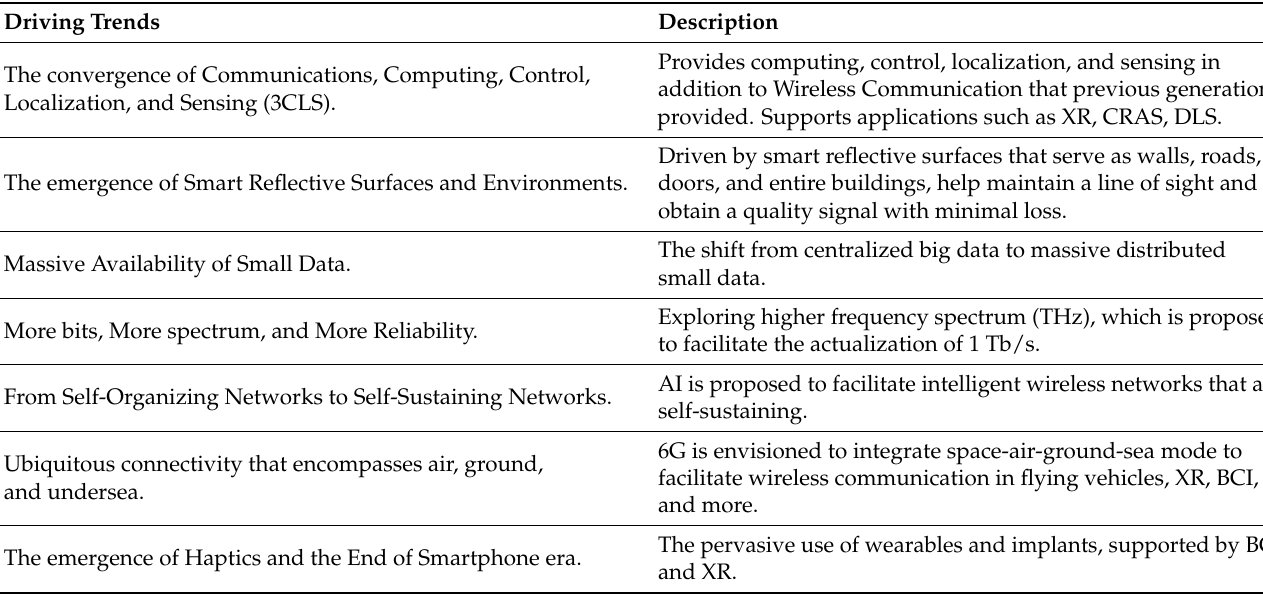
Figure 2. Comparative Analysis of 5G and 6G Key Performance Indicators.